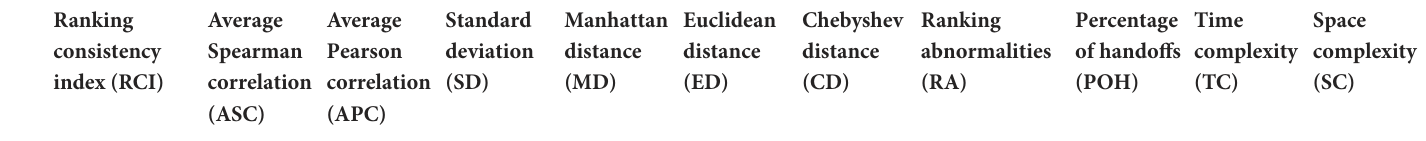
TABLE 3 Summary of articles according to the comparison metrics